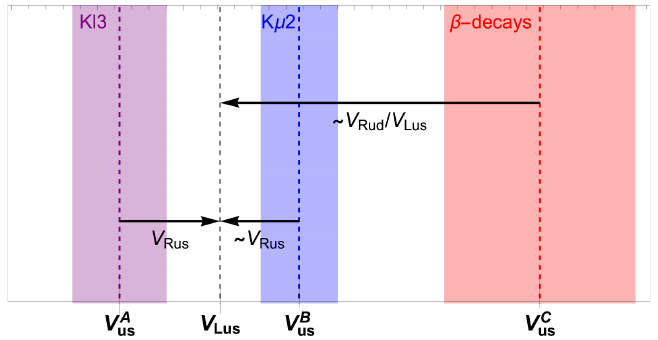
, V B and V C in us us us : | V | = 2 ud = − 0 . 74(29) · 10 − 3 with Rud